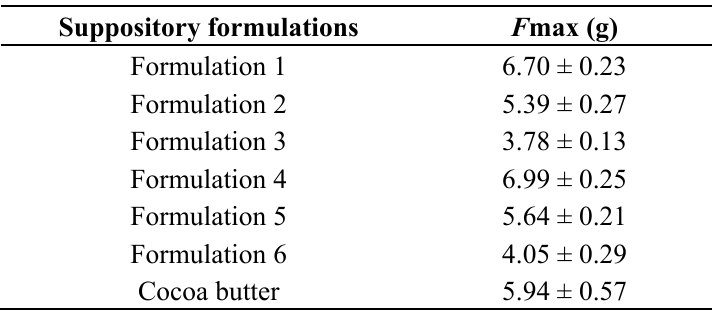
Table 2. Bioadhesive force of suppository